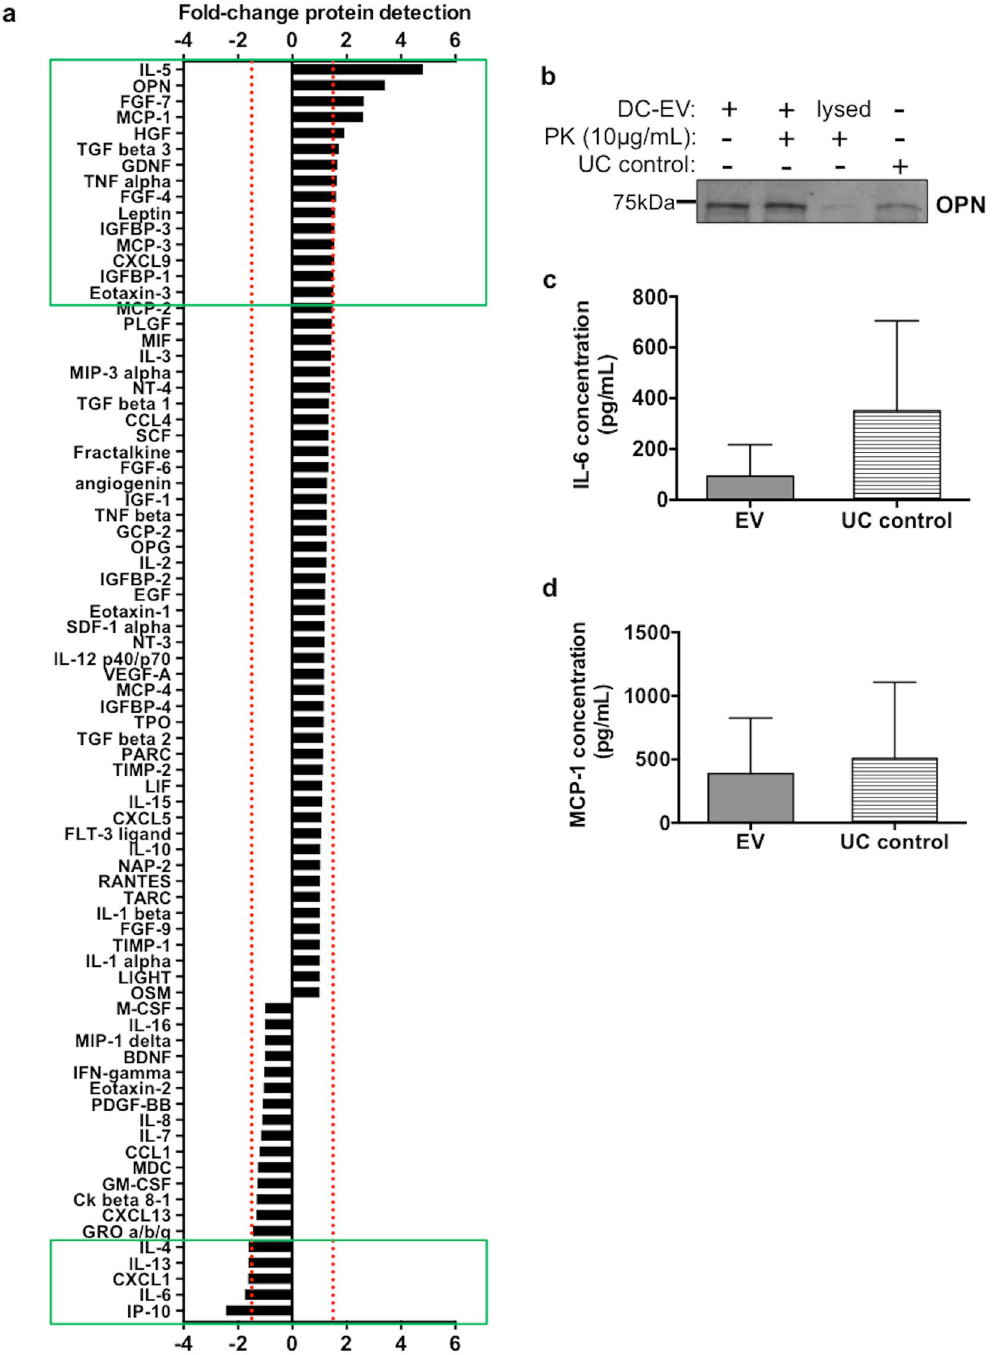
Figure 5. DC-derived EV are enriched in mediators with reported chemoattractant properties. ( a ) Chemokines and growth factors enriched/depleted in DC-EV comparatively to DC conditioned media, as assayed by antibody array. Red dashed lines represent the fold-change thresholds of 1.5 and − 1.5. Mediators with an absolute fold-change ≥ 1.5 are highlighted by the green box. See also Supplementary Fig. S2. ( b ) Detection of osteopontin (OPN) in the DC-derived EV fraction (DC-EV) and 100 K supernatant (UC control) by western blot. Proteinase K (PK) digestion, before or after vesicle lysis, were performed as indicated. Full gel scan is available in Supplementary Fig. S5. Relative concentration (average ± SD) of ( c ) IL-6 and ( d ) MCP-1 in DC- derived EV (after proteinase K digestion) and 100 K supernatant (UC control), as determined by ELISA. For all assays, EV, 100 K supernatant and conditioned media from 3 different DC donors were pooled